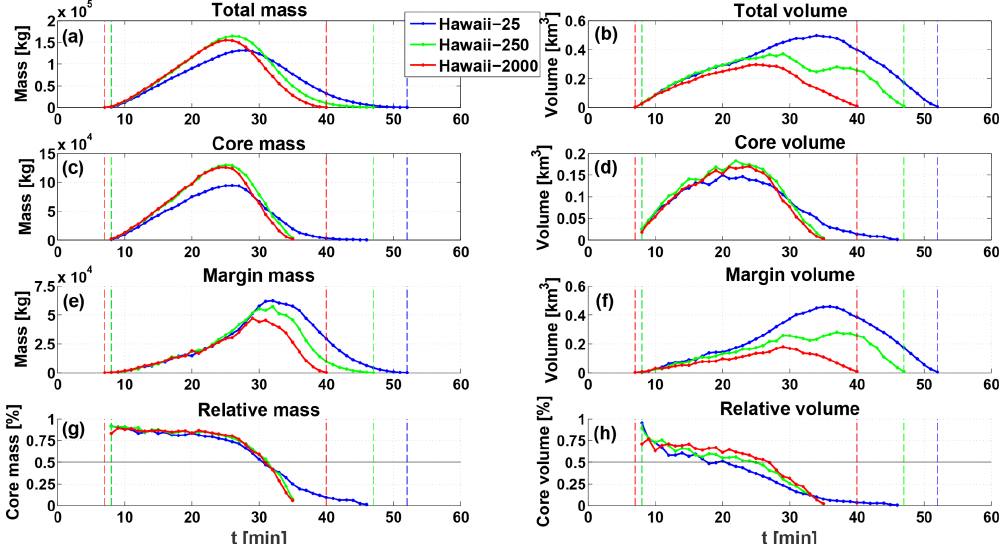
Figure 3. Time series of cloud mass (kg; a, c, e, g ) and cloud volume (km 3 ; b, d, f, h ) for the different aerosol concentrations simulations (see legend). The total (a, b) , core (c, d) , margin (e, f) , and relative fraction (g, h) values are shown for each parameter, as indicated by panel titles. The core here is defined according to RH > 100% definition.